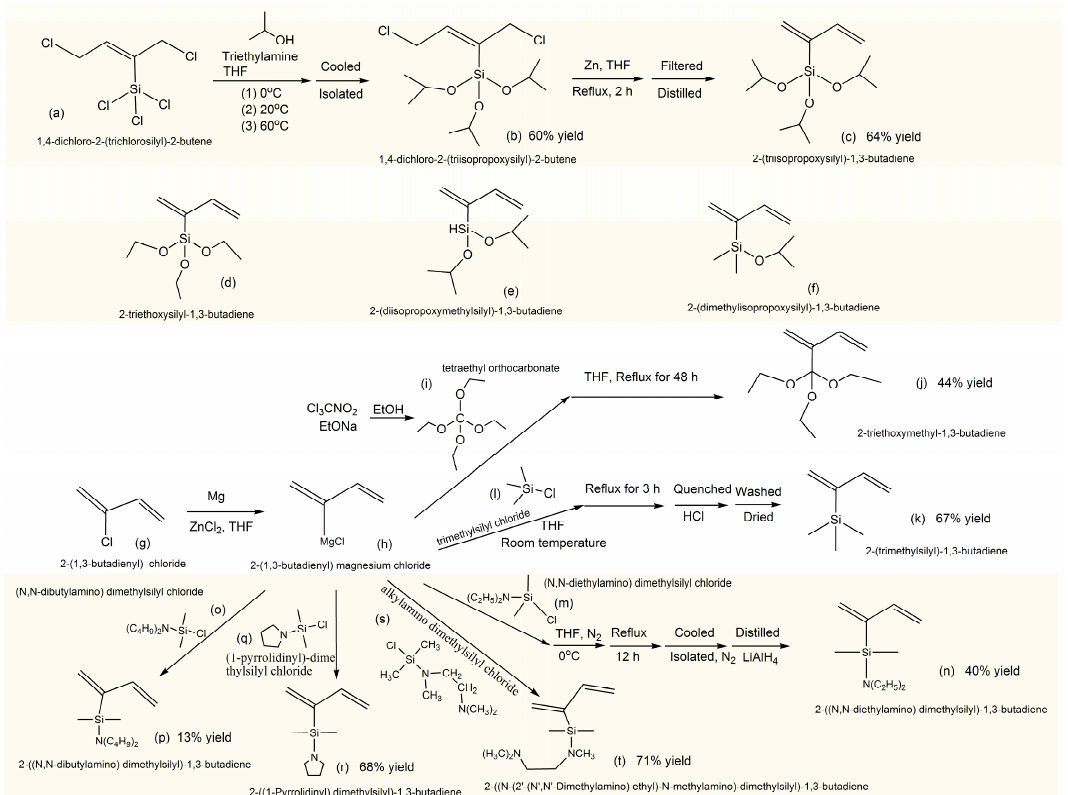
Figure 14. Synthesis of 2-substituted 1,3-butadienes [135,147–151].